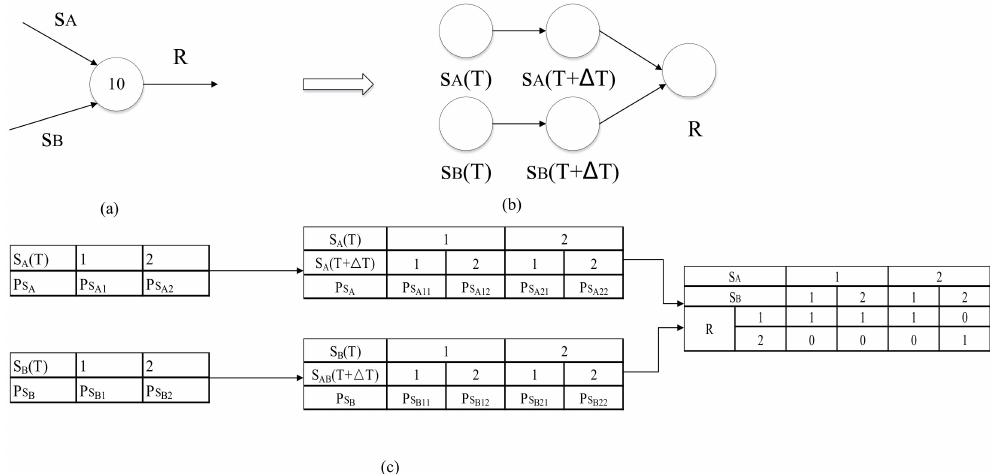
Figure 9. The dynamic Bayesian network corresponding to operator 10. ( a ) is the operator 10, ( b ) is the corresponding initial network and transition network, and ( c ) is the conditional probability table of each